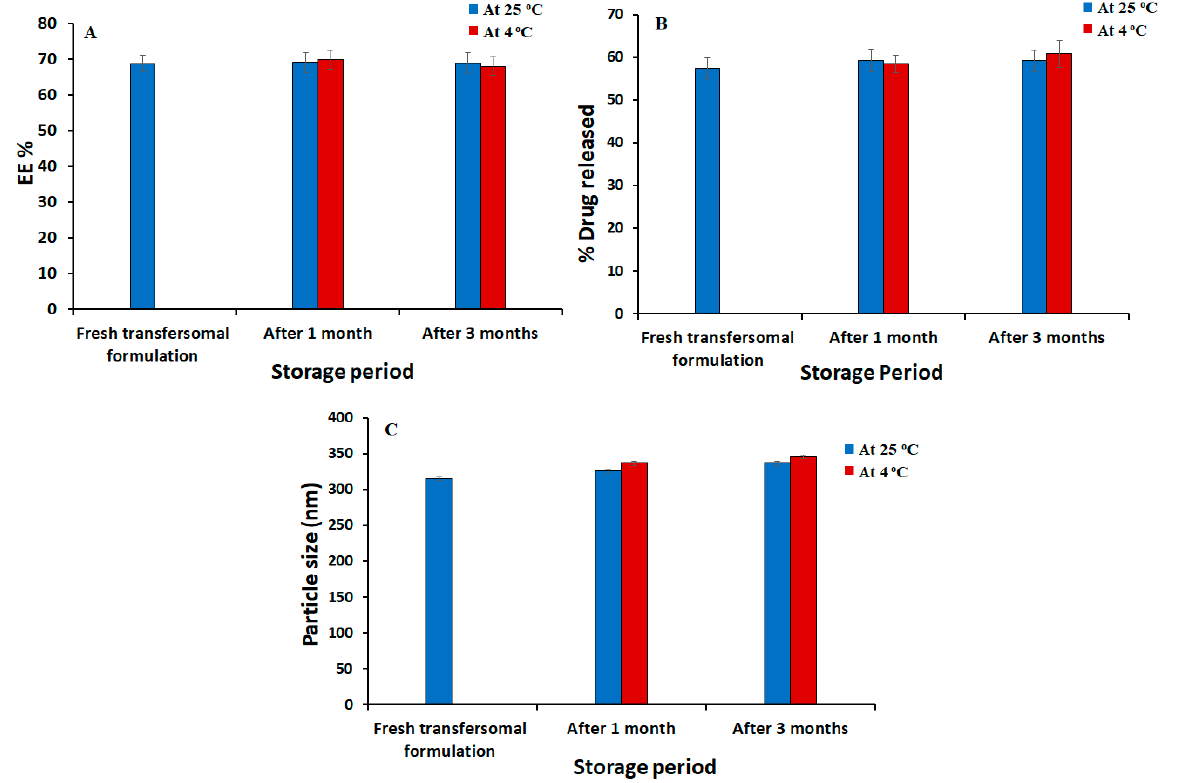
Figure 5. Outline of stability study for optimized Silymarin loaded transfersomal formulation for 1 and 3 months at 4 °C and 25 °C in terms of ( A ) EE%; ( B ) In vitro drug release and ( C ) Particle size (nm) in comparison to freshly prepared formulation.